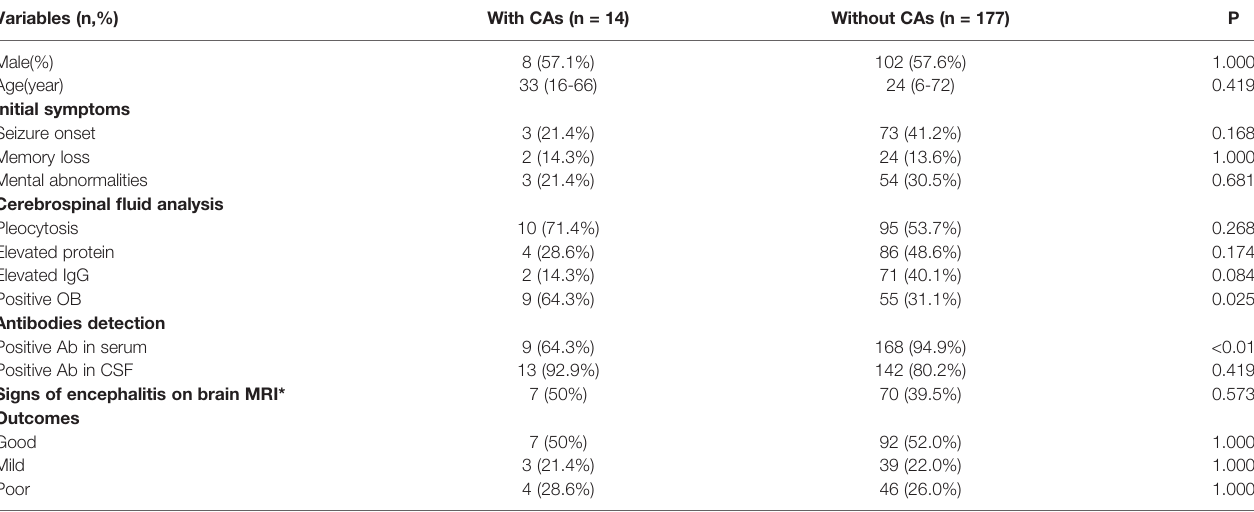
TABLE 2 | Comparison of clinical characteristic of patients positive for NASbs with and without CAs. Variables (n,%)